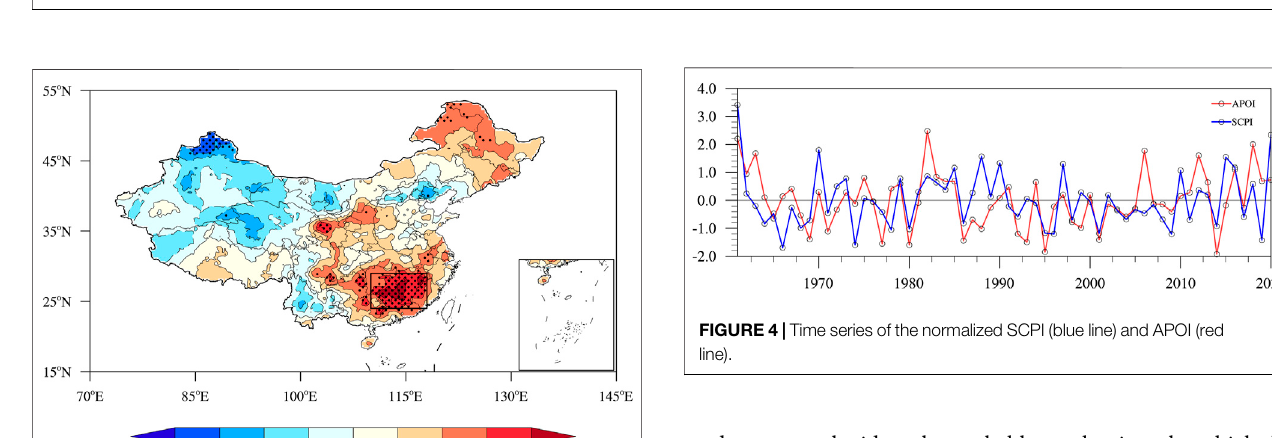
FIGURE 2 | Correlation coef fi cients of the September precipitation anomalies over China and the (A) summer mean, (B) June, (C) July, and (D) August APOI. Stippled regions indicate statistical signi fi cance above the 95% con fi dence level.